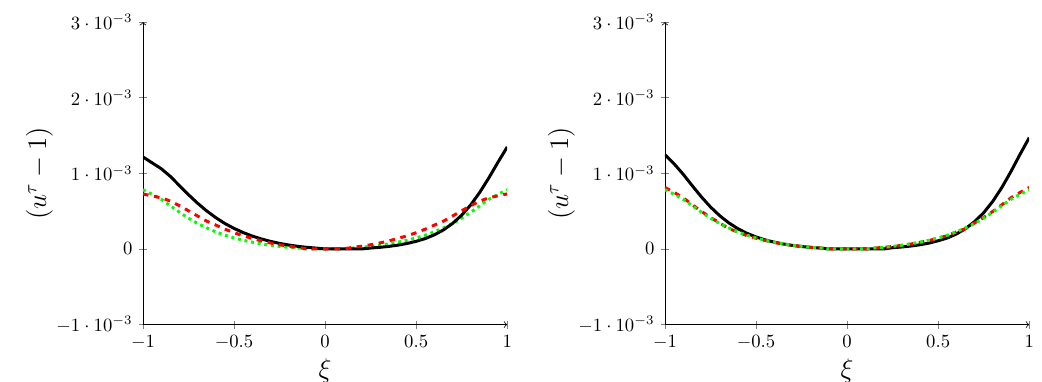
Figure 5 . Left: the di(cid:11)erence of the proper time component of the (cid:13)uid velocity from unity, u (cid:28) (cid:0) 1, plotted as a function of rapidity at proper time (cid:28) = 3 for the asymmetric collision ( w (0 : 075 ; 0 : 35) (black line) and the symmetric collisions w (cid:6) = 0 : 075 (red dashed line) and w (cid:6) = 0 : 35 (green dotted line). Right: the analogous comparison for the asymmetric collision ( w (0 : 075 ; 0 : 25) (black line), and corresponding symmetric collisions w (cid:6) = 0 : 075 (red dashed line) and w (cid:6) = 0 : 25 (green dotted line). As in ref. [1] we (cid:12)nd that u (cid:28) (cid:25) 1 with a deviation of a few parts in